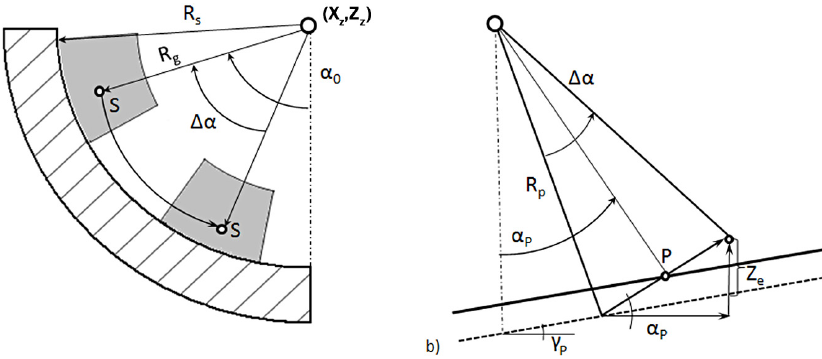
Fig. 5. (a) Main parameters of rotational slider block model: centre of gravity ( S ), radius to centre of gravity (Rg), radius to sliding surface (Rs), initial sliding angle ( α 0), rotation during slide ( 1α) ; (b) sketch visualizing the calculation of the Eulerian vertical movement at point P: radius (Rp) and angle ( αp ) to P, surface slope ( γp ), uplift at P (Ze).